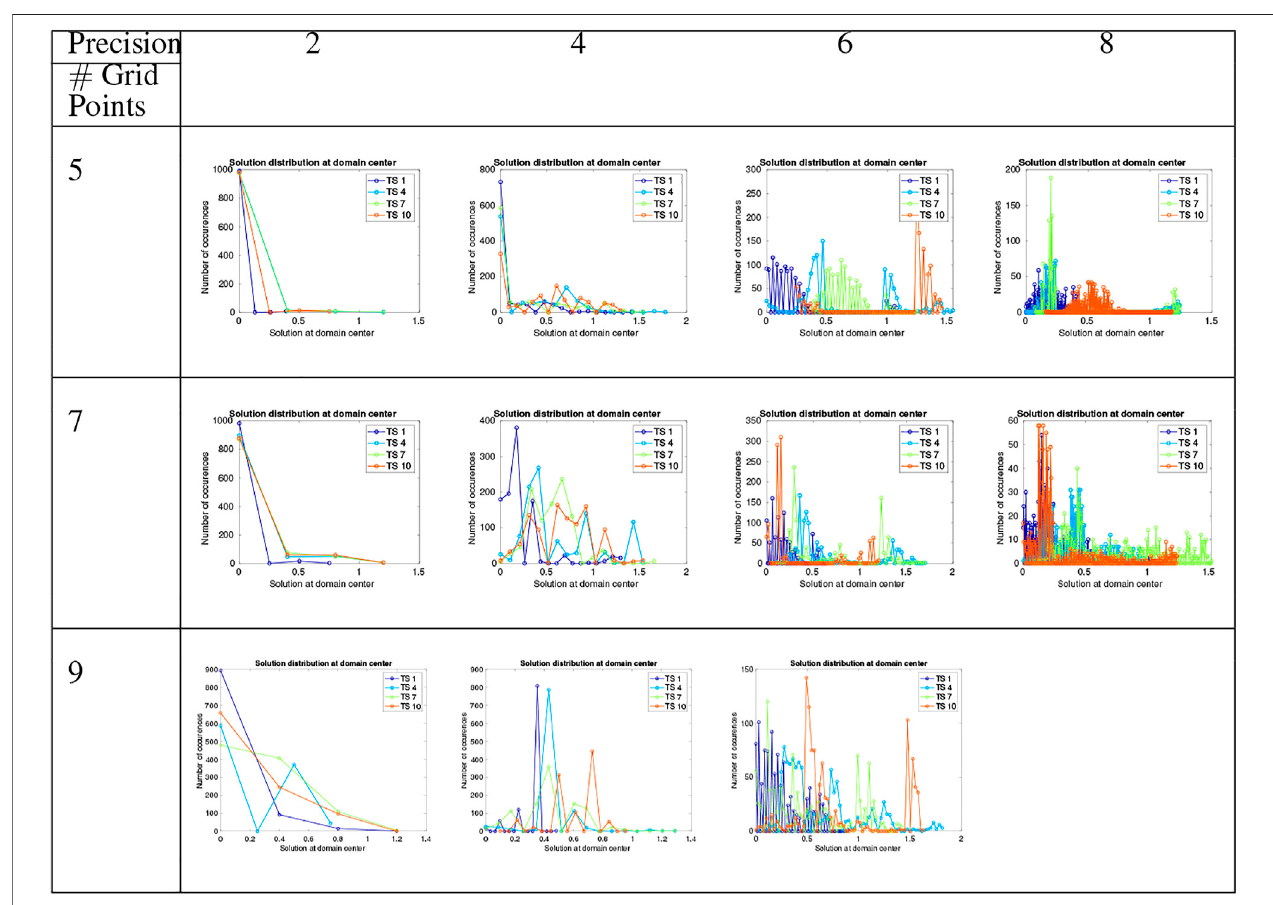
FIGURE 7 | Solution distribution at domain